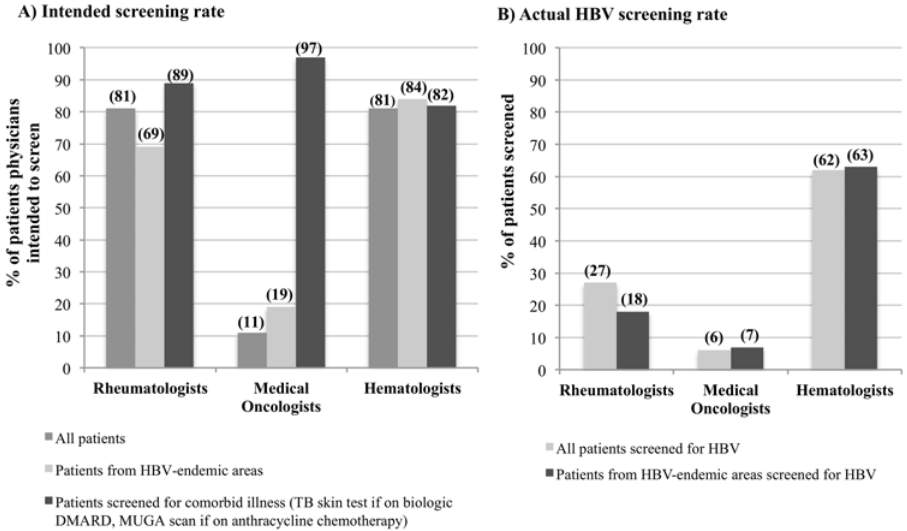
Fig 2. Screening practices of physicians prior to immunosuppressive therapy. A) The proportion of patients identified to merit screening for HBV prior to immunosuppressive therapy in each specialty are shown. This is contrasted with the proportion of patients requiring TB screening before biologic DMARDs (rheumatology) and cardiac testing prior to anthracycline-based chemotherapy (hematologists/oncologists). B) The rates of planned screening are contrasted with the actual rate of HBV screening for HBV prior to immunosuppressive therapy for all patients and for the sub-group of patients from HBV-endemic